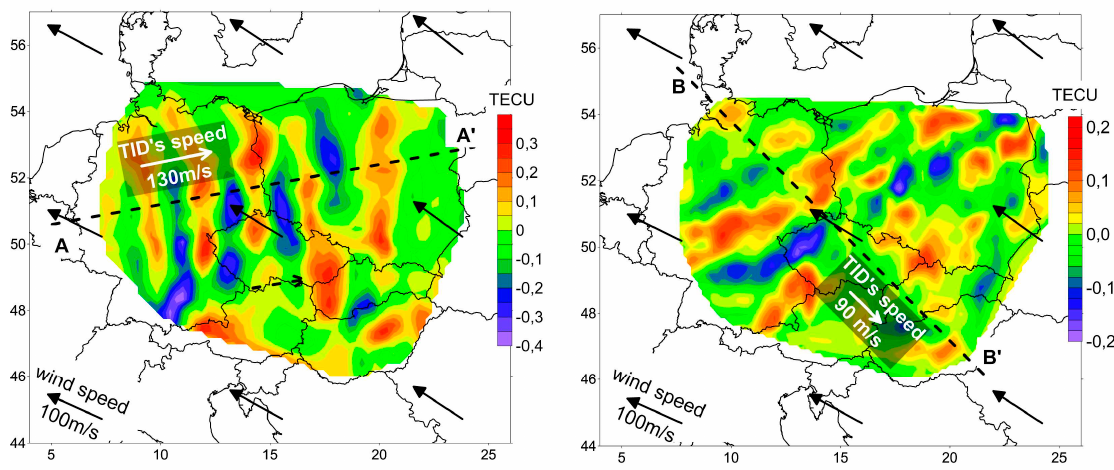
Figure 7. Map of TEC variations over investigated region of 13, March 2013 at 08h50m ( left ) and of 13, March 2015 at 08h50m ( right ).